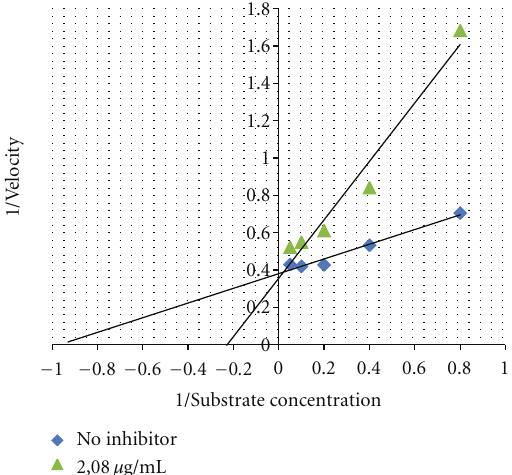
Figure 1: Lineweaver-Burk plot of 80% ethanol extract of leaves of Antidesma celebicum with concentration of 2.08 μ g/mL with pNPG substrate concentration of 1.25, 2.5, 5, 10, and 20mM.